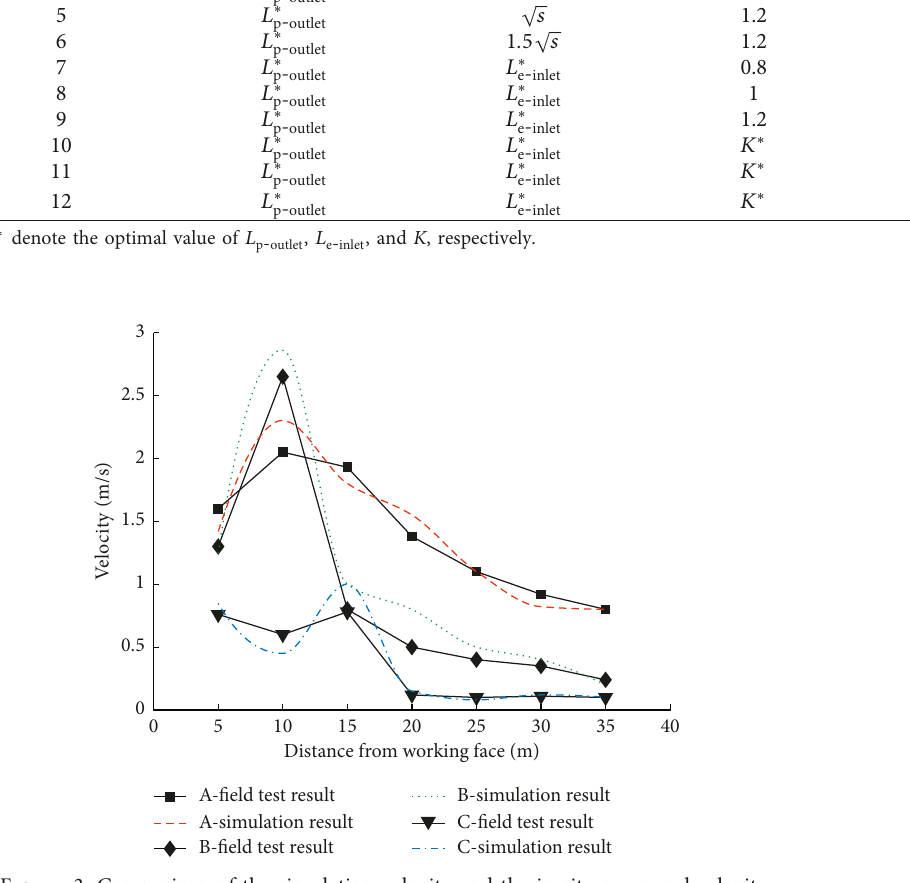
Figure 3: Comparison of the simulation velocity and the in situ measured velocity.